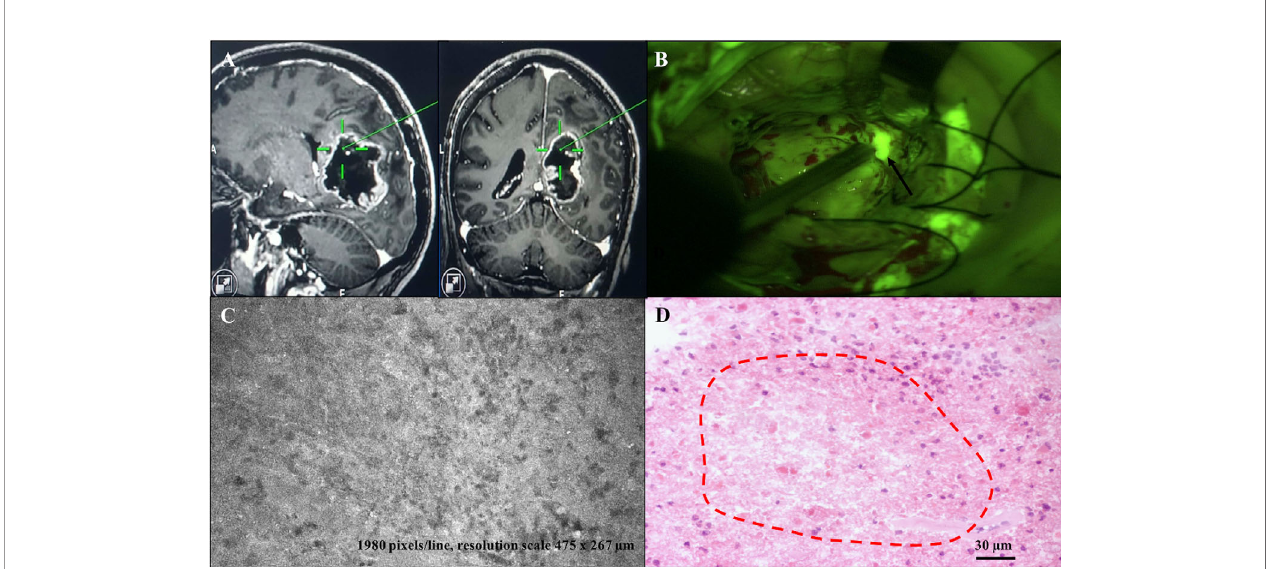
FIGURE 3 | Diagnostic partially concordant case: right parieto-occipital GBM (case n. 14). (A) Neuronavigation MR images showing the site of “ A ” biopsy sampling in the GBM core. (B) Intraoperative view during tumor removal with SF-guided technique. Yellowish fl uorescent areas under Y560 fi lter activation of the surgical microscope correspond to tumor tissue (site of “ A ” sampling, black arrow). (C, D) CONVIVO ® and permanent section images, respectively, within the biopsy sample, showing an area of tumor tissue with prevalent necrotic aspects, such as low cellular density, prevalence of amorphous tissue on an intermediate fl uorescence background (C) , con fi rmed as a low-cellular density necrotic area within the permanent section sample (red-dotted lines in D